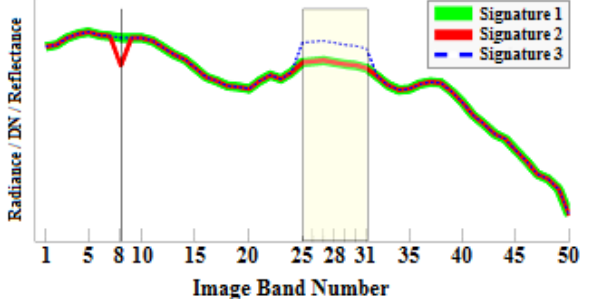
Figure 1. Spectral space: Distinct signatures revealed due to the appearance of a band (e.g., band 8) or a highly correlated spectral region (e.g., bands 25~31). Signature 2 is revealed by band 8 and signature 3 is diagnosed by the spectral region containing bands 25 ~